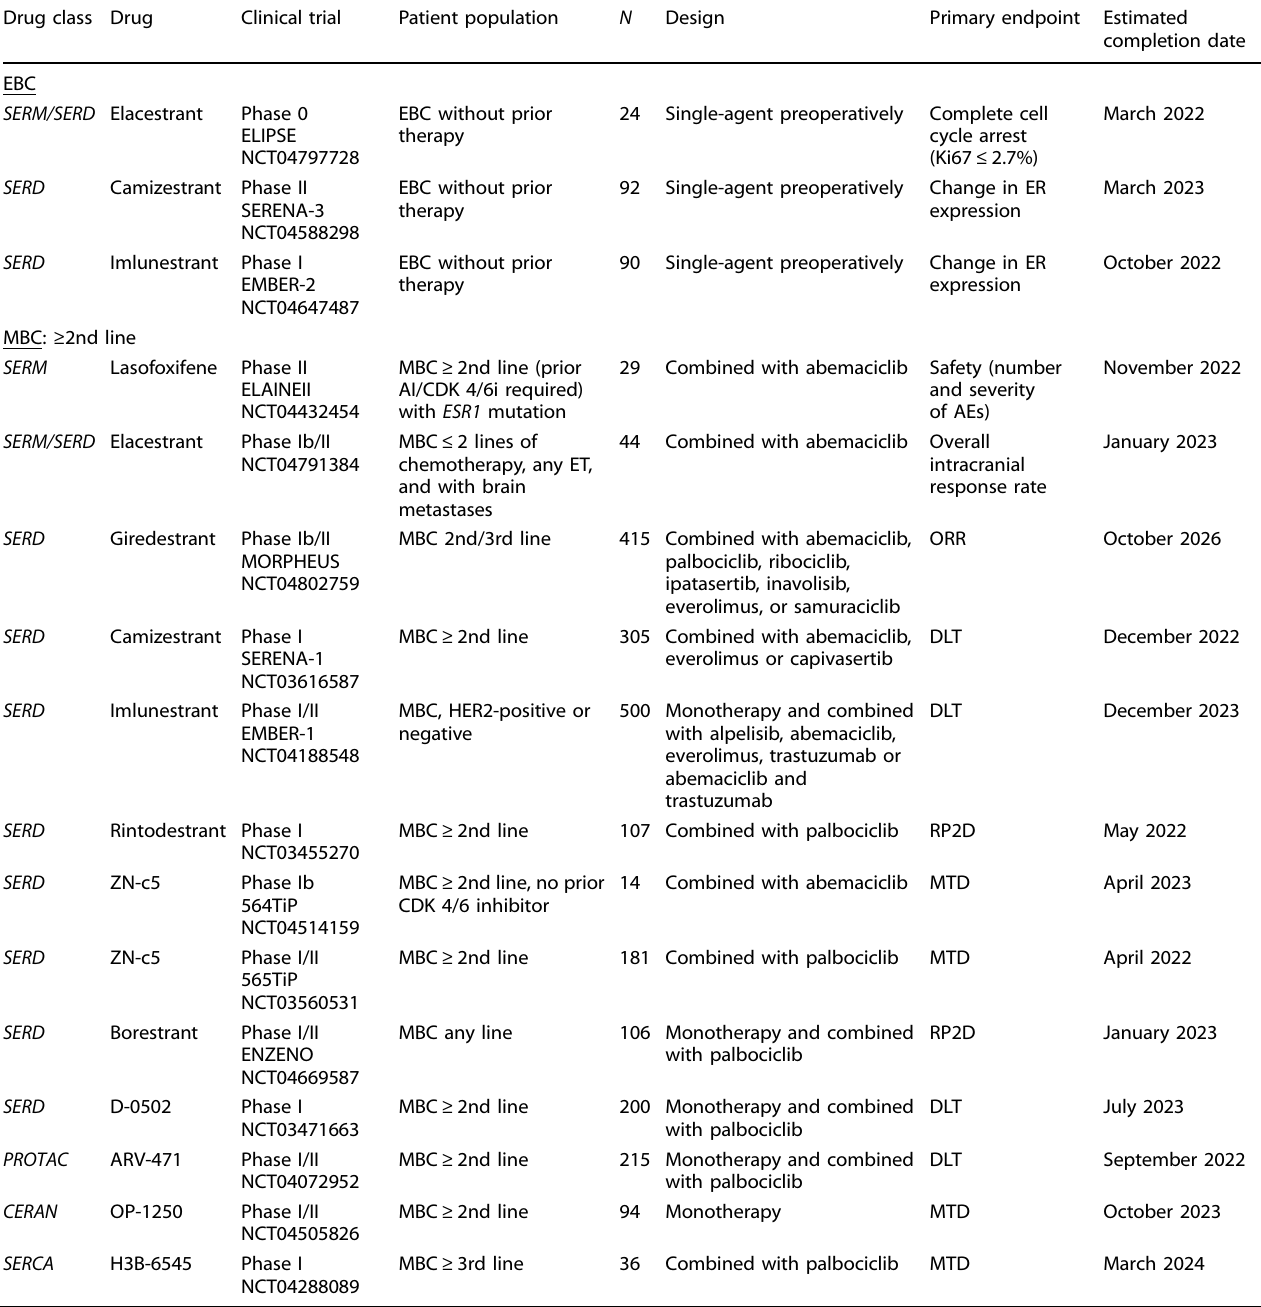
Table 5. Ongoing non-randomized trials of novel anti-estrogen